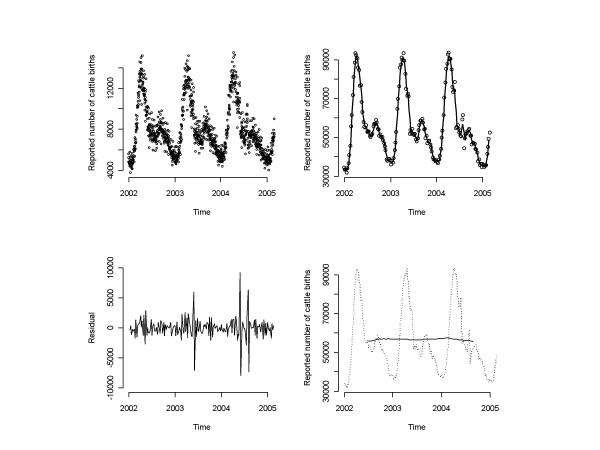
Time series for cattle births reported to BCMS over the period 1st Jan 2002 and 28th Feb 2005. (a) Raw data plotted at daily intervals (b) 3-point moving average (raw weekly data shown as unconnected symbols) (c) Residuals after accounting for the 3-point moving average (d) 53-point moving average (raw weekly data shown as unconnected symbols).